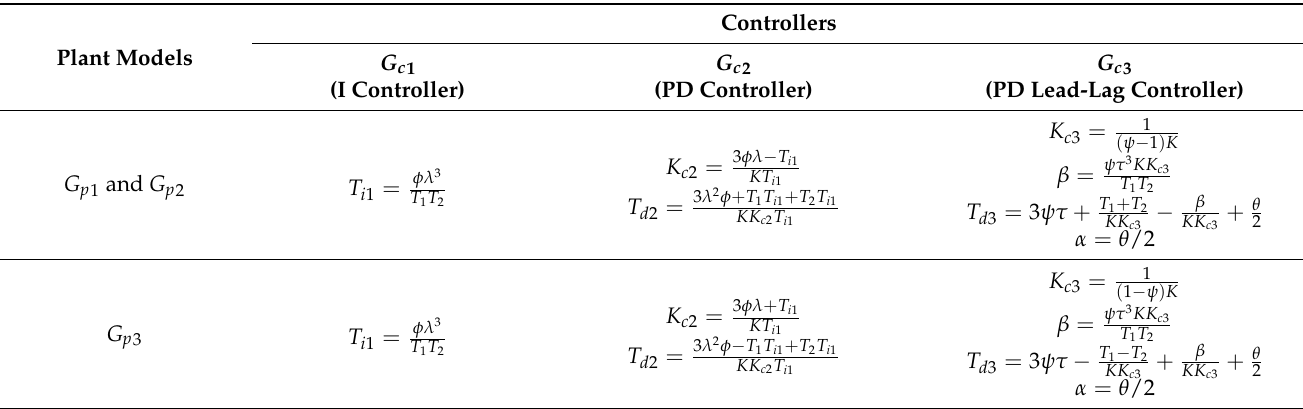
Table 1. Plant models and controller parameter